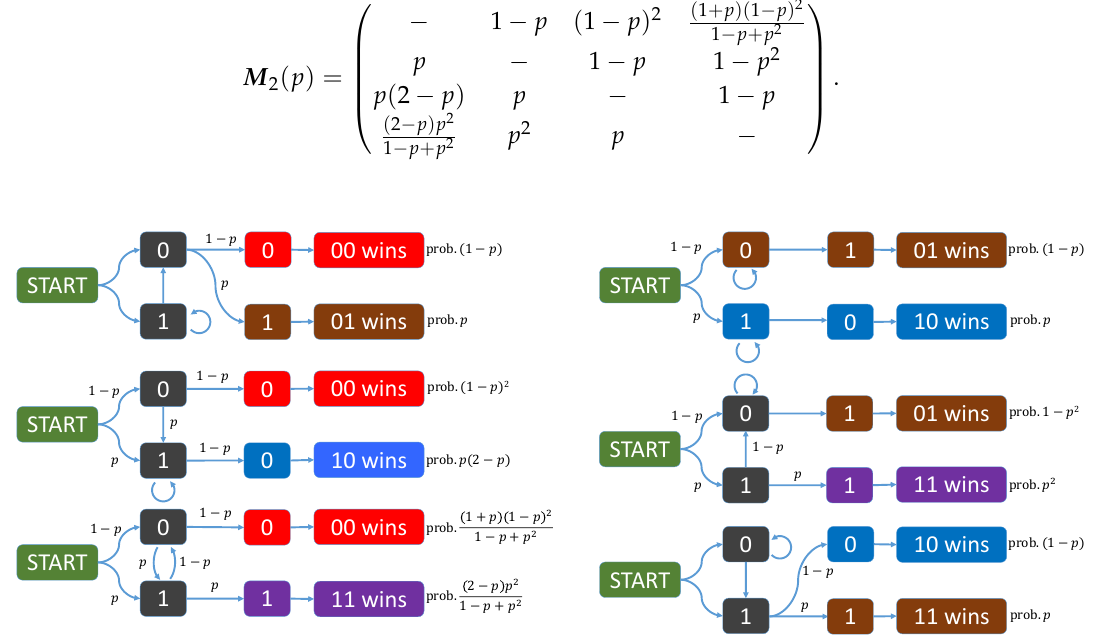
Figure 2. Complete analysis of the Penney Game for (cid:96) = 2 and loaded